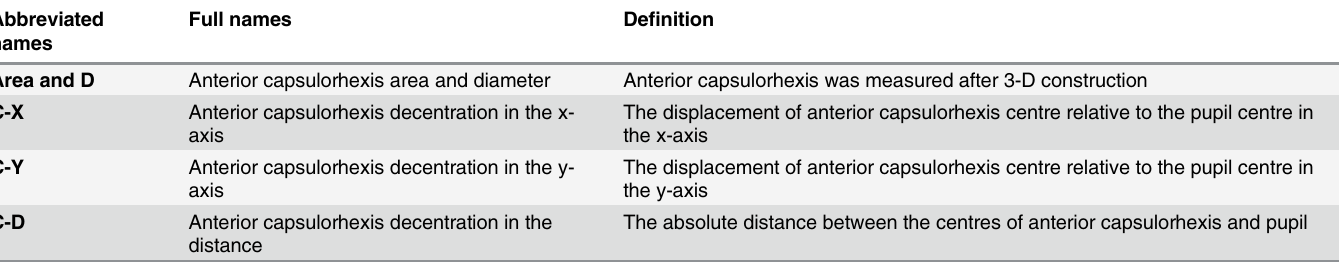
Table 3. Parameters definition of anterior capsulorhexis position after three-dimensional (3-D) construction of anterior segment.